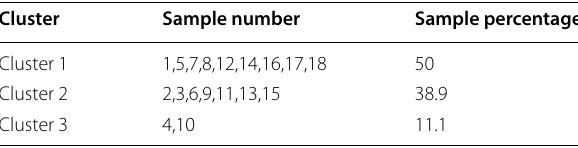
Table 5 Cluster analysis of the soil samples Cluster